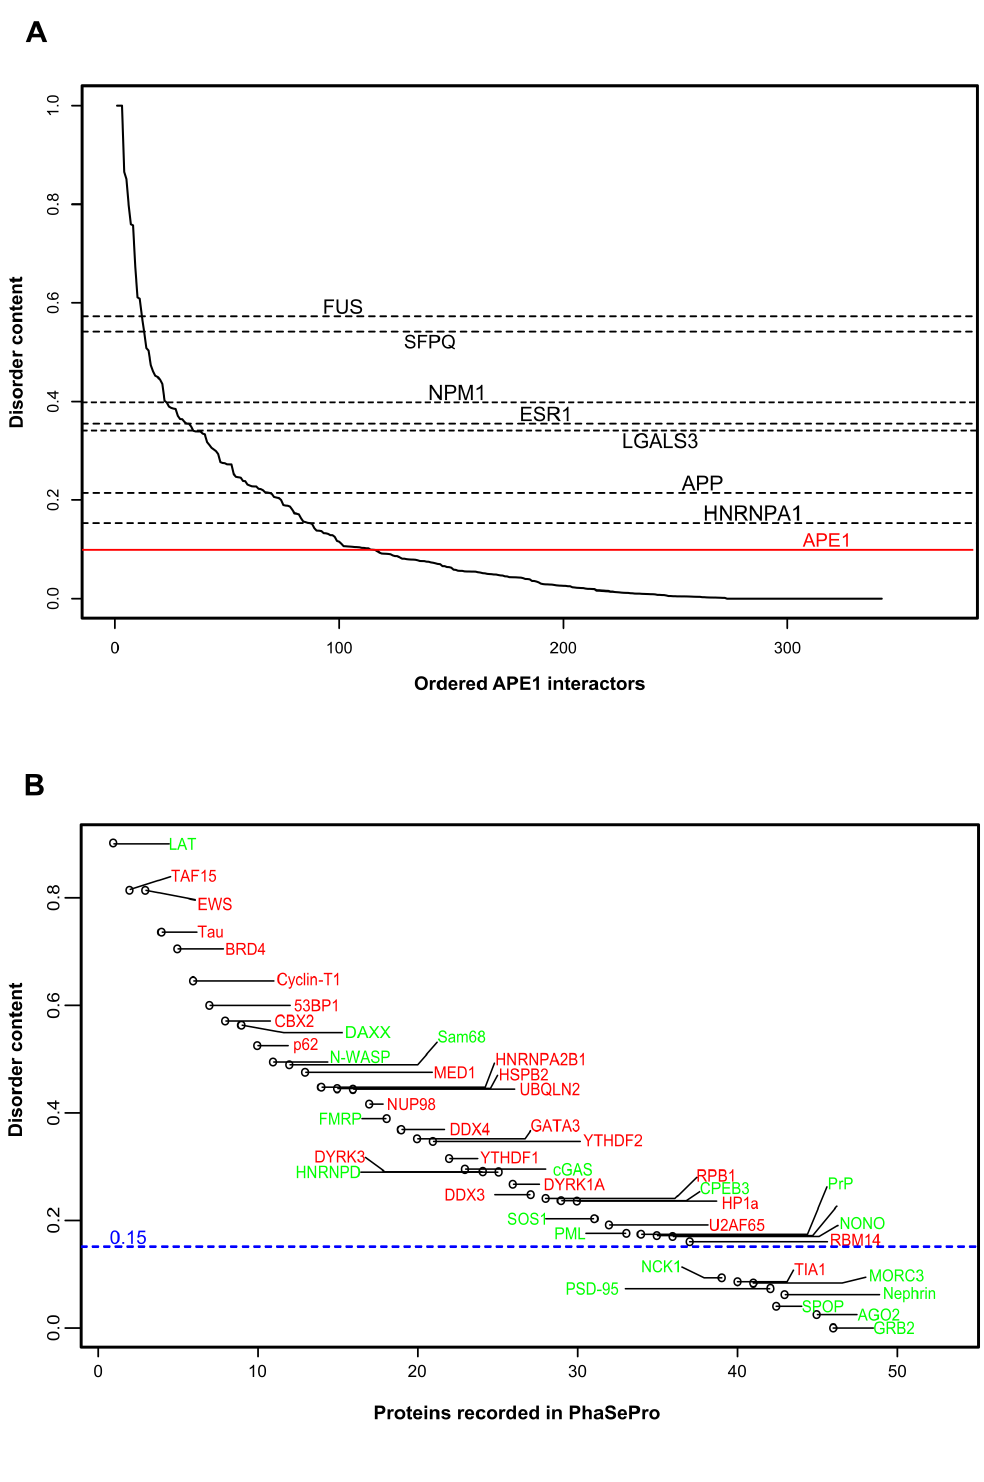
Figure 2: Distribution of the examined proteins disorder content. (A) APE1 protein interactors, ordered by decreasing disorder content as retrieved from MobiDB, are identified by their position in the list of interactors. Dashed, horizontal lines highlight the position of the APE1 interactors known to undergo phase-separation according to PhaSePro. APE1 level of disorder is also highlighted by a red, solid line. (B) PhaSePro proteins, ordered by decreasing disorder content as retrieved from MobiDB, are colored according to the necessity (green) or independence (red) for a demixing partner. The blue dashed line highlights the 0.15 threshold in disorder content used to select proteins for functional